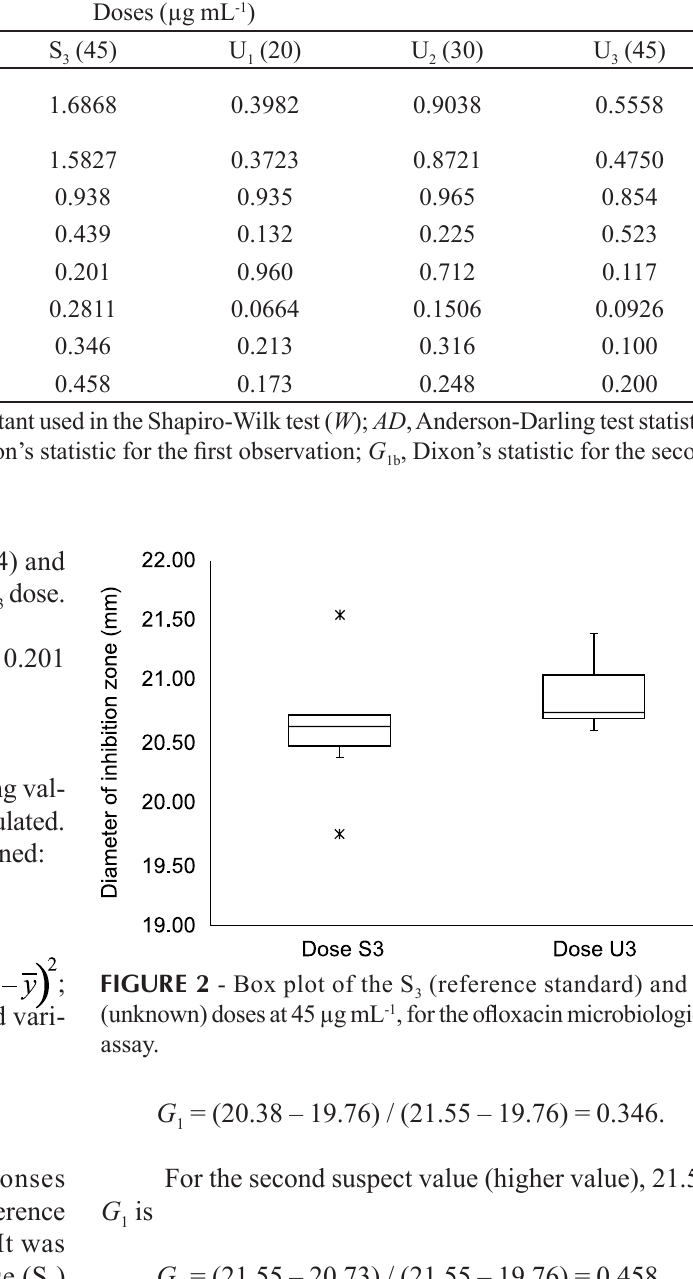
FIGURE 2 - Box plot of the S (unknown) doses at 45 µg mL -1 , for the ofloxacin microbiological